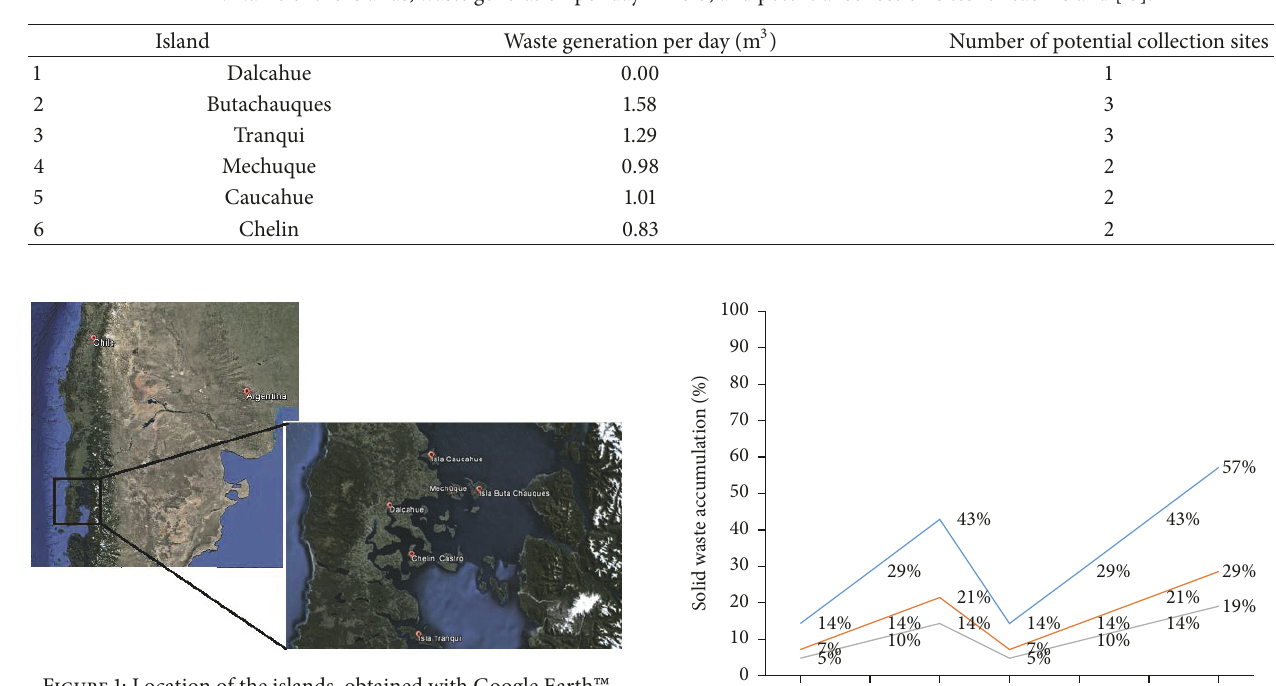
Figure 1: Location of the islands, obtained with Google Earth (cid:2) .